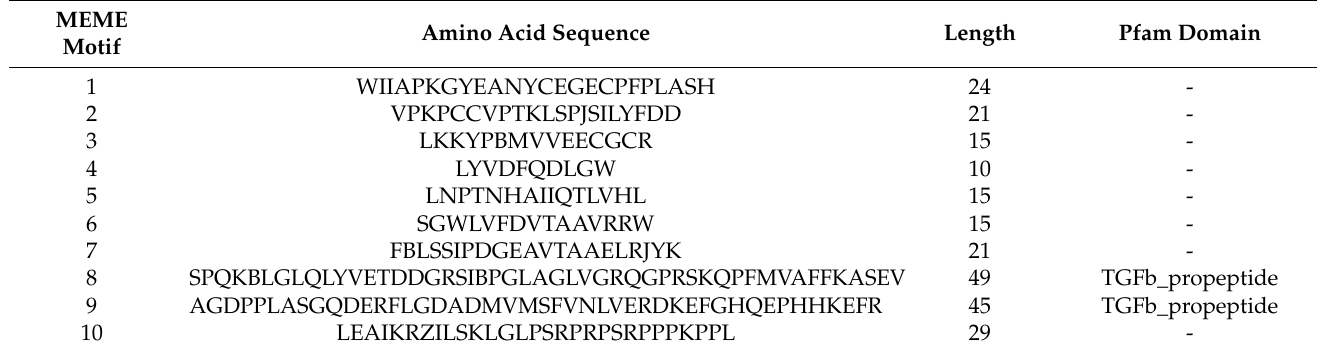
Table 1. Ten substantially conserved motifs identified in TGF- β gene family of buffalo.